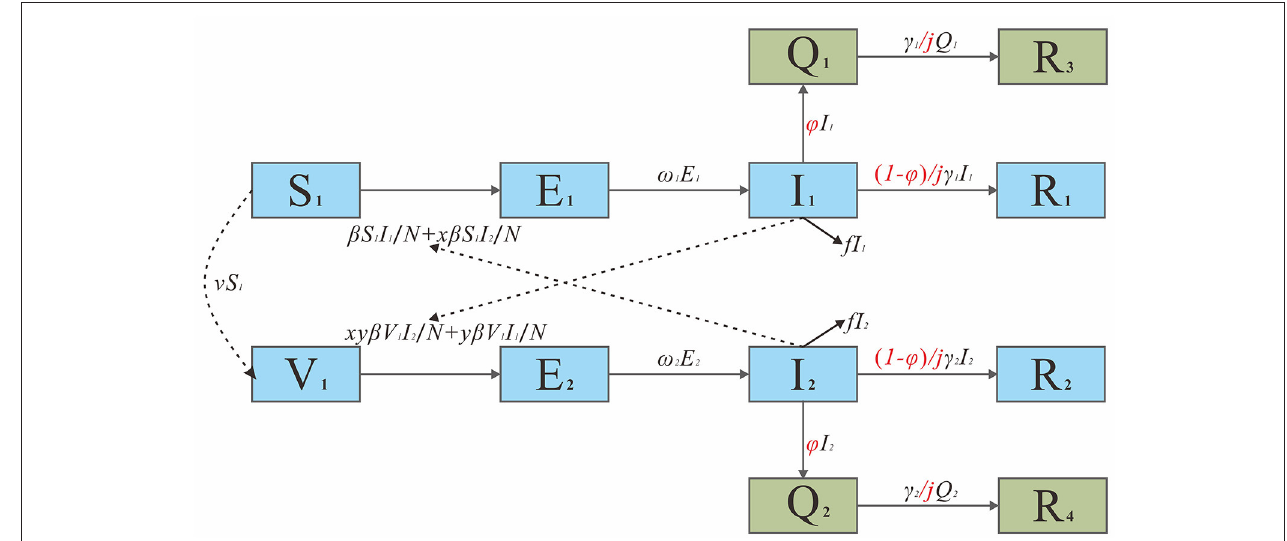
FIGURE 1 | The framework of SEIRQV model of intervention effect